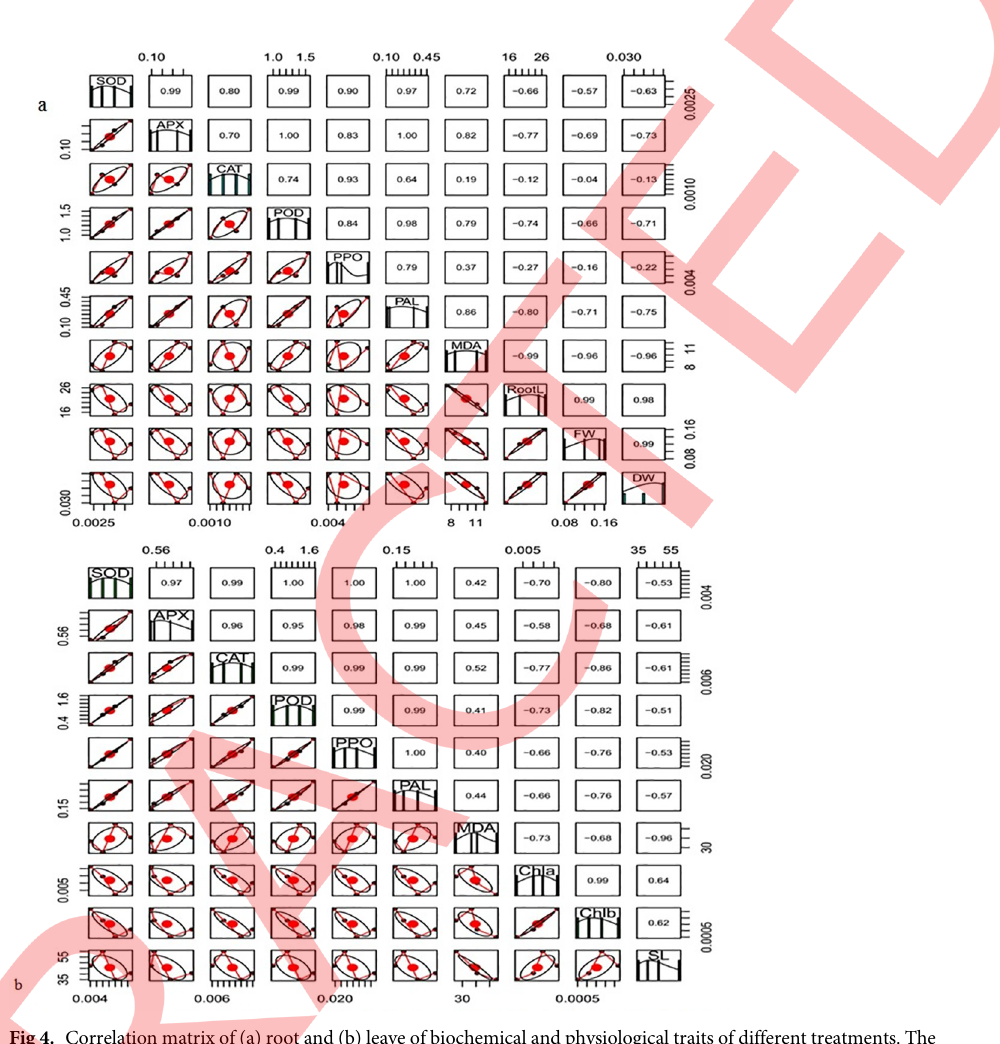
Fig 4. Correlation matrix of (a) root and (b) leave of biochemical and physiological traits of different treatments. The name of the parameters was presented on diagonal line. The upper side of the figure depicted correlation coefficient and the lower side of figure showed the